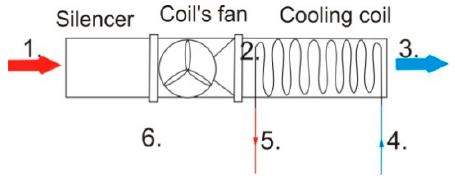
Figure 4. Air-cooler with the measuring points indicated.